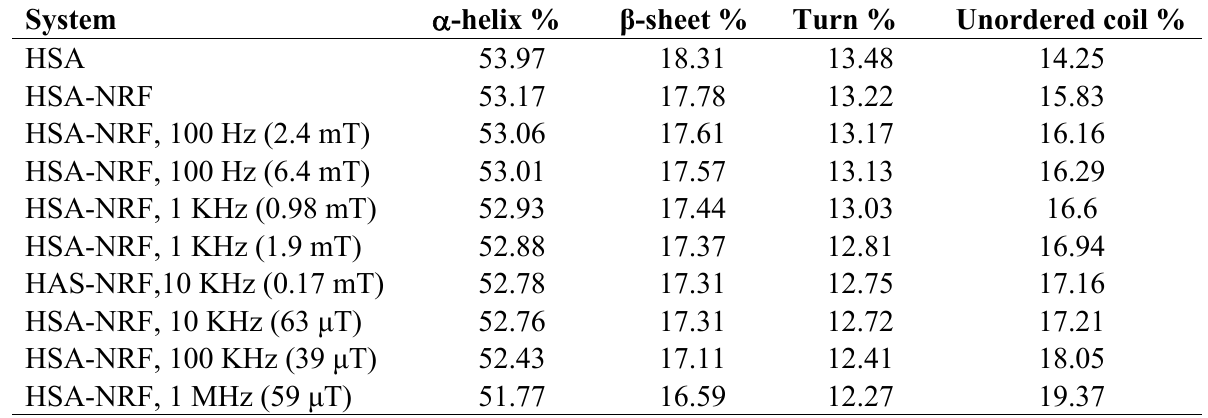
Table 5. Secondary structural analysis of the HSA-NRF systems from CD data in the absence and presence of